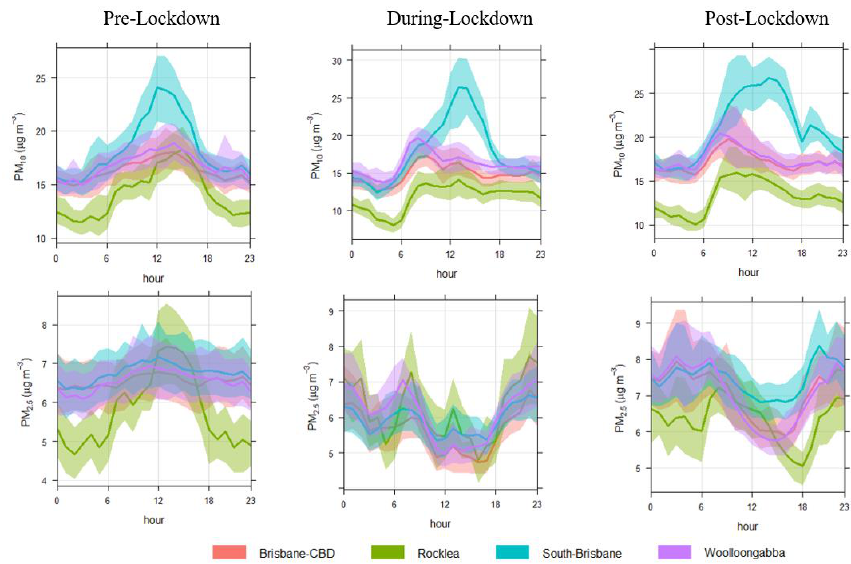
Figure 5. Hourly diurnal profile of PM 10 and PM 2.5 concentrations at different monitoring stations during various periods.